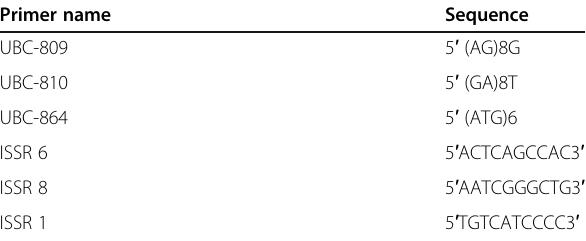
Table 2 Names and sequences of ISSR primers used